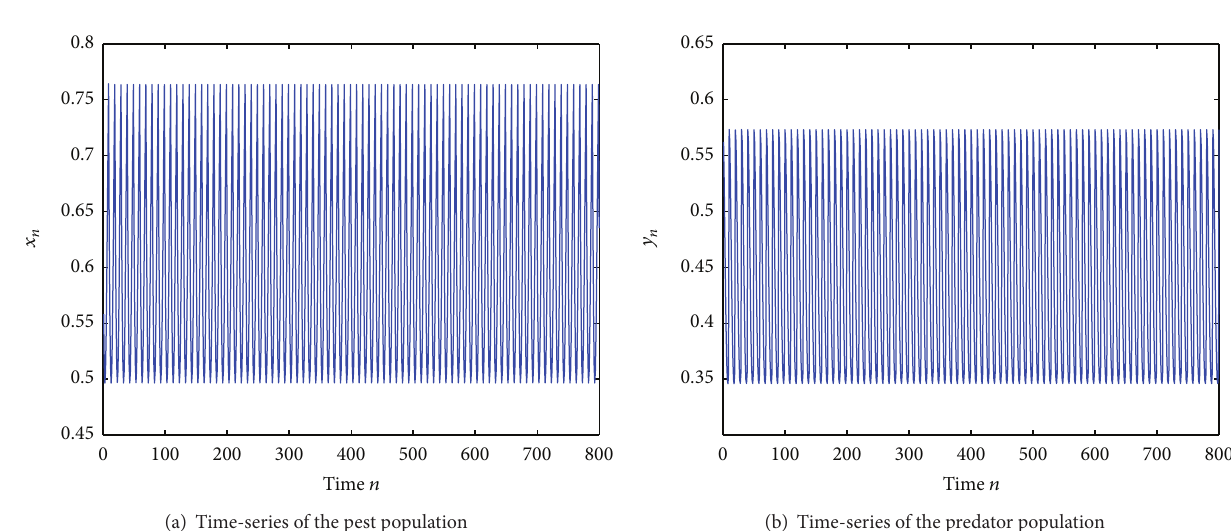
Figure 2: Dynamical behavior of the pest-predator system of